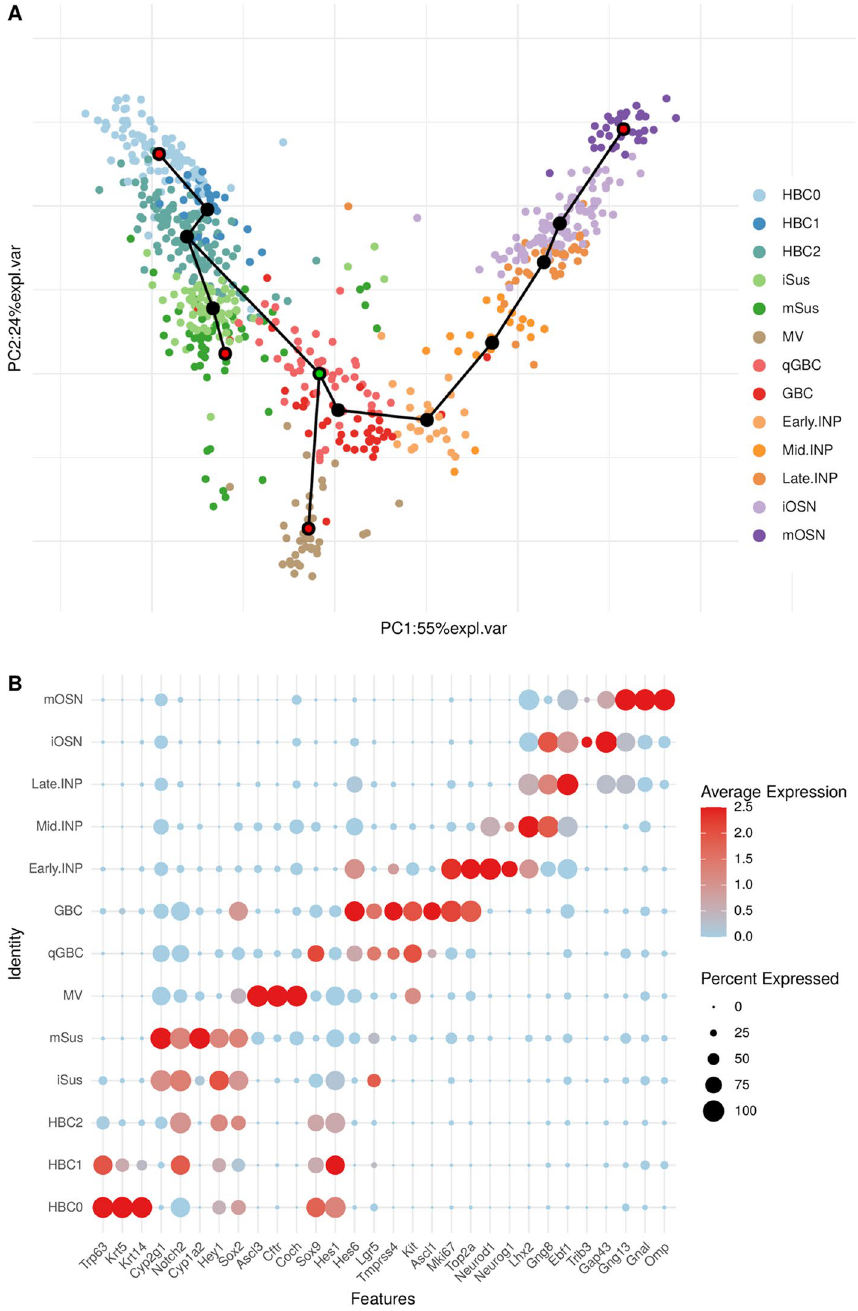
Figure 1. Cell type identification, trajectory inference and pseudotime assignment. ( A ) 2D PCA projection of MOE cells shows the four predicted lineages starting from qGBC (center, pink, the starting point of the four trajectories is marked in green). The differentiation trajectory end points (red dots at the end of paths) are HBC0 (top left, pale blue), mSus (center left, green), MV (bottom, brown) and mOSN (top right, purple). The transition stages in the four lineages (black dots) are HBC1 (light blue), HBC2 (blue), iSus (light green), GBC (red), early.INP (pale orange), mid.INP (light orange), late.INP (dark orange) and iOSN (light purple) from the left to the right. ( B ) DotPlot representation of the average expression (red for high and pale blue for low expression) of known marker genes (x.axis) corresponding to cell types of MOE (y.axis), and the size of each dot represents the percentage of cells that expresses a corresponding marker gene in a given cell